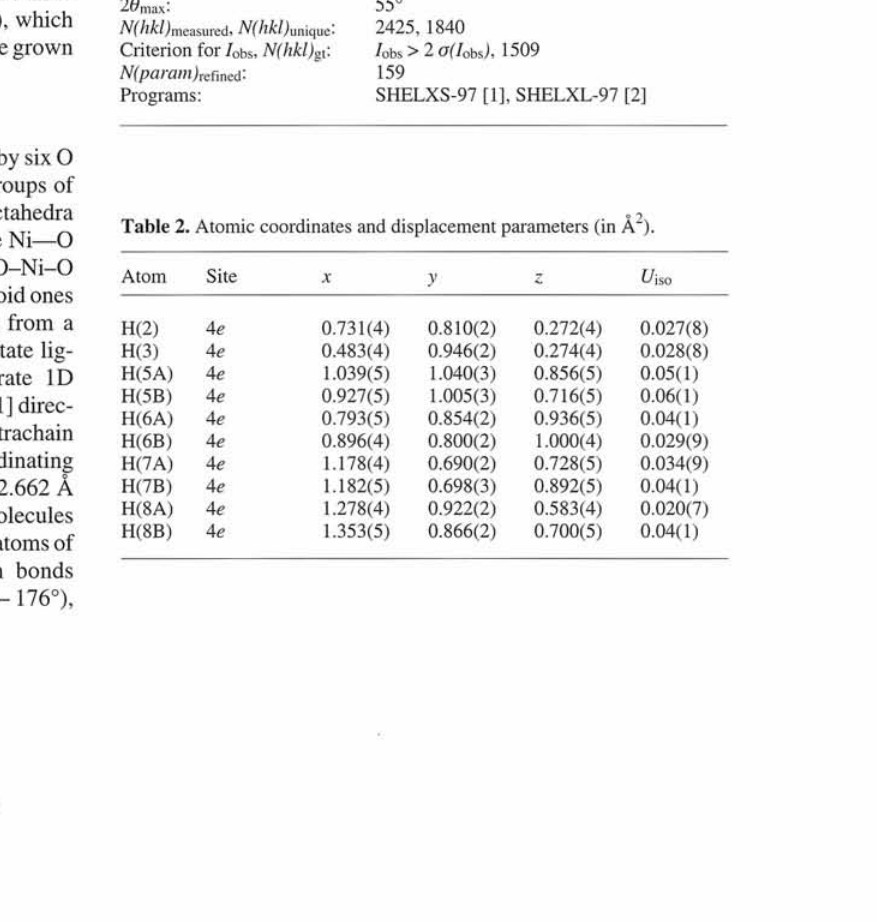
Table 1. Data collection and handling. Crystal: